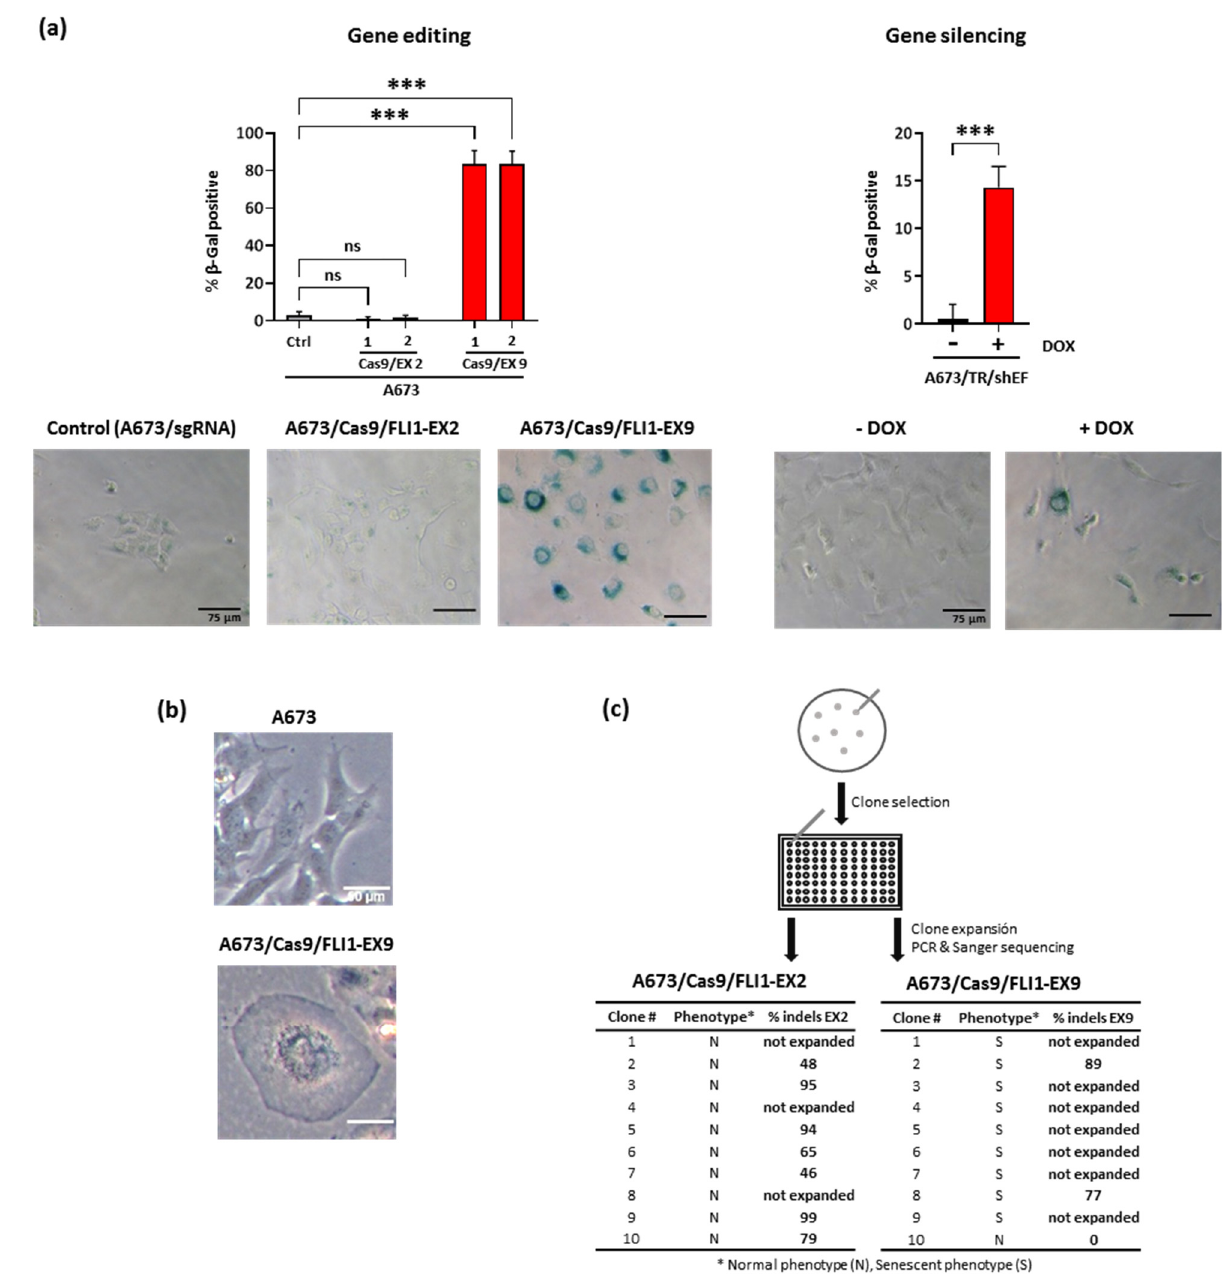
Figure 4. EWSR1–FLI1 gene inactivation induced generalized senescence. ( a ) β -Galactosidase activity was measured in control (Ctrl) cells (A673/sgRNA) and A673/Cas9/sgRNA cells using a β -galactosidase activity assay. β -Galactosidase-positive cells were counted, and the percentage of positive cells were determined. The graphs represent the results of two independent experiments performed with MOI = 1 (1) and MOI = 5 (2). The A673/TR/shEF cells were stimulated with doxycycline (1 µg/mL) for 7 days to induce the expression of the EWSR1–FLI1-specific shRNA (mean ± Scheme 0. Student’s t -test). Representative micrographs of each cell line are also shown. ( b ) Representative micrographs of A673 and A673/Cas9/FLI1-EX9 cells, showing the characteristic appearance of senescent cells in A673/Cas9/FLI1–EX9 cells. ( c ) The A673/Cas9/sgRNAs cells were seeded at a low density and then isolated clones were reseeded independently in 96-well plates. Afterward, Sanger sequencing/ICE CRISPR analysis was performed for each clone to determine the gene edition percentage (% indels). The tables show the phenotype of each picked-up clone, if it expand after reseeding and the percentage of gene edition.